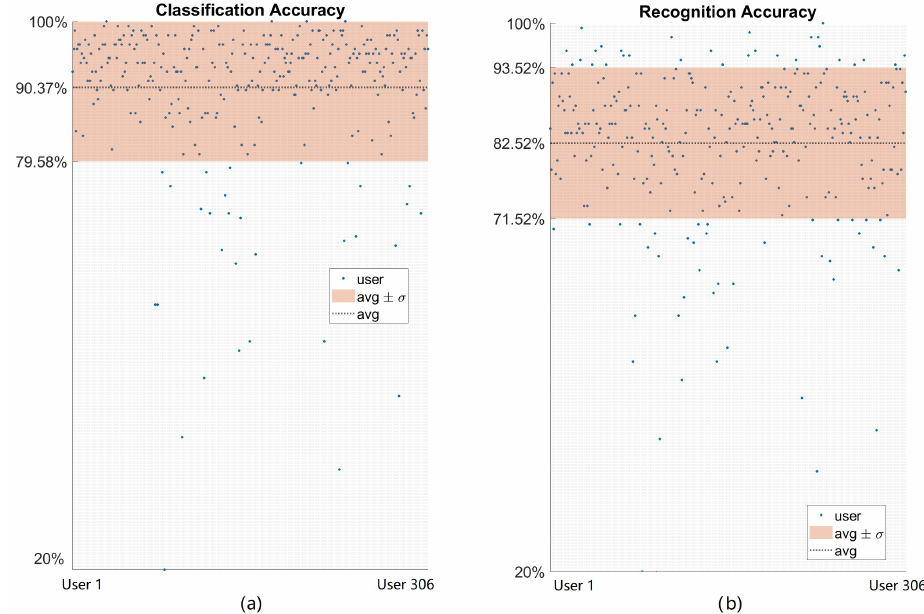
Figure 11. User-specific HGR model results for each of the 306 users of test set with the best hyperparameter configuration: ( a ) classification results; ( b ) recognition